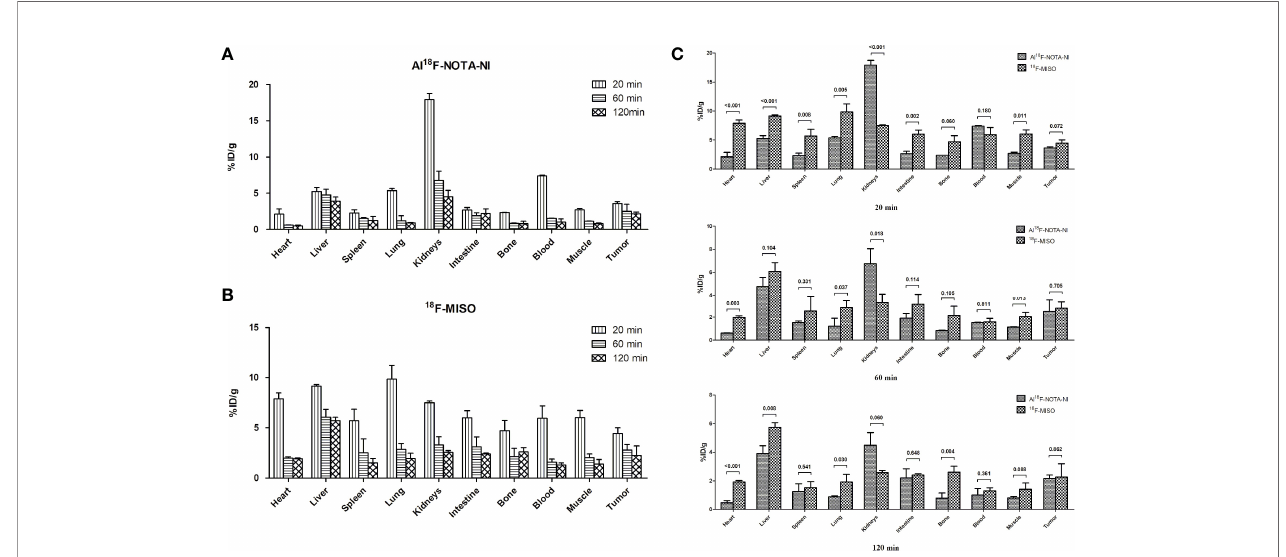
FIGURE 5 | (A) Percentages of injected dose per gram of tissue (%ID/g ± SD) in major organs of xenografted mice at 20, 60, and 120 min p.i. for Al 18 F-NOTA-NI (n = 3 per time point). (B) Percentages of injected dose per gram of tissue (%ID/g ± SD) in major organs of xenografted mice at 20, 60, and 120 min p.i. for Al 18 F- NOTA-NI (n = 3 per time point). (C) Uptake value (%ID/g ± SD) of Al 18 F-NOTA-NI in comparison with that of 18 F-MISO in the same kind of organ at 20, 60, and 120 min p.i (n = 3 per time